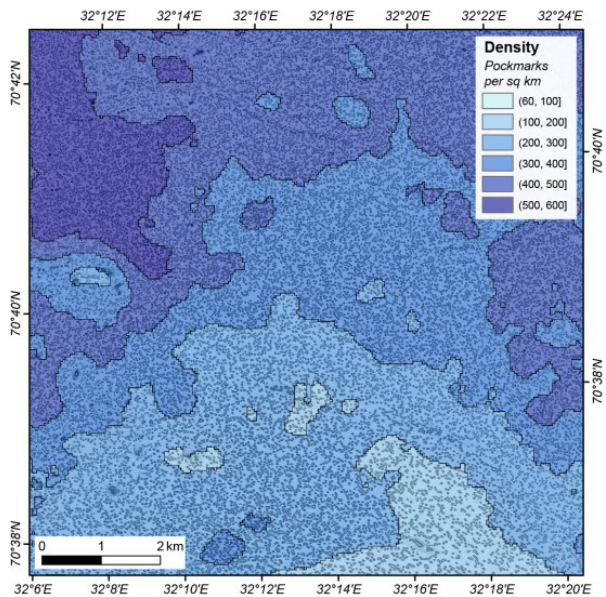
Figure 25. Pockmark density and distribution map of the Barents Sea study area, obtained using the mapping results from the BGS Seabed Mapping Toolbox.